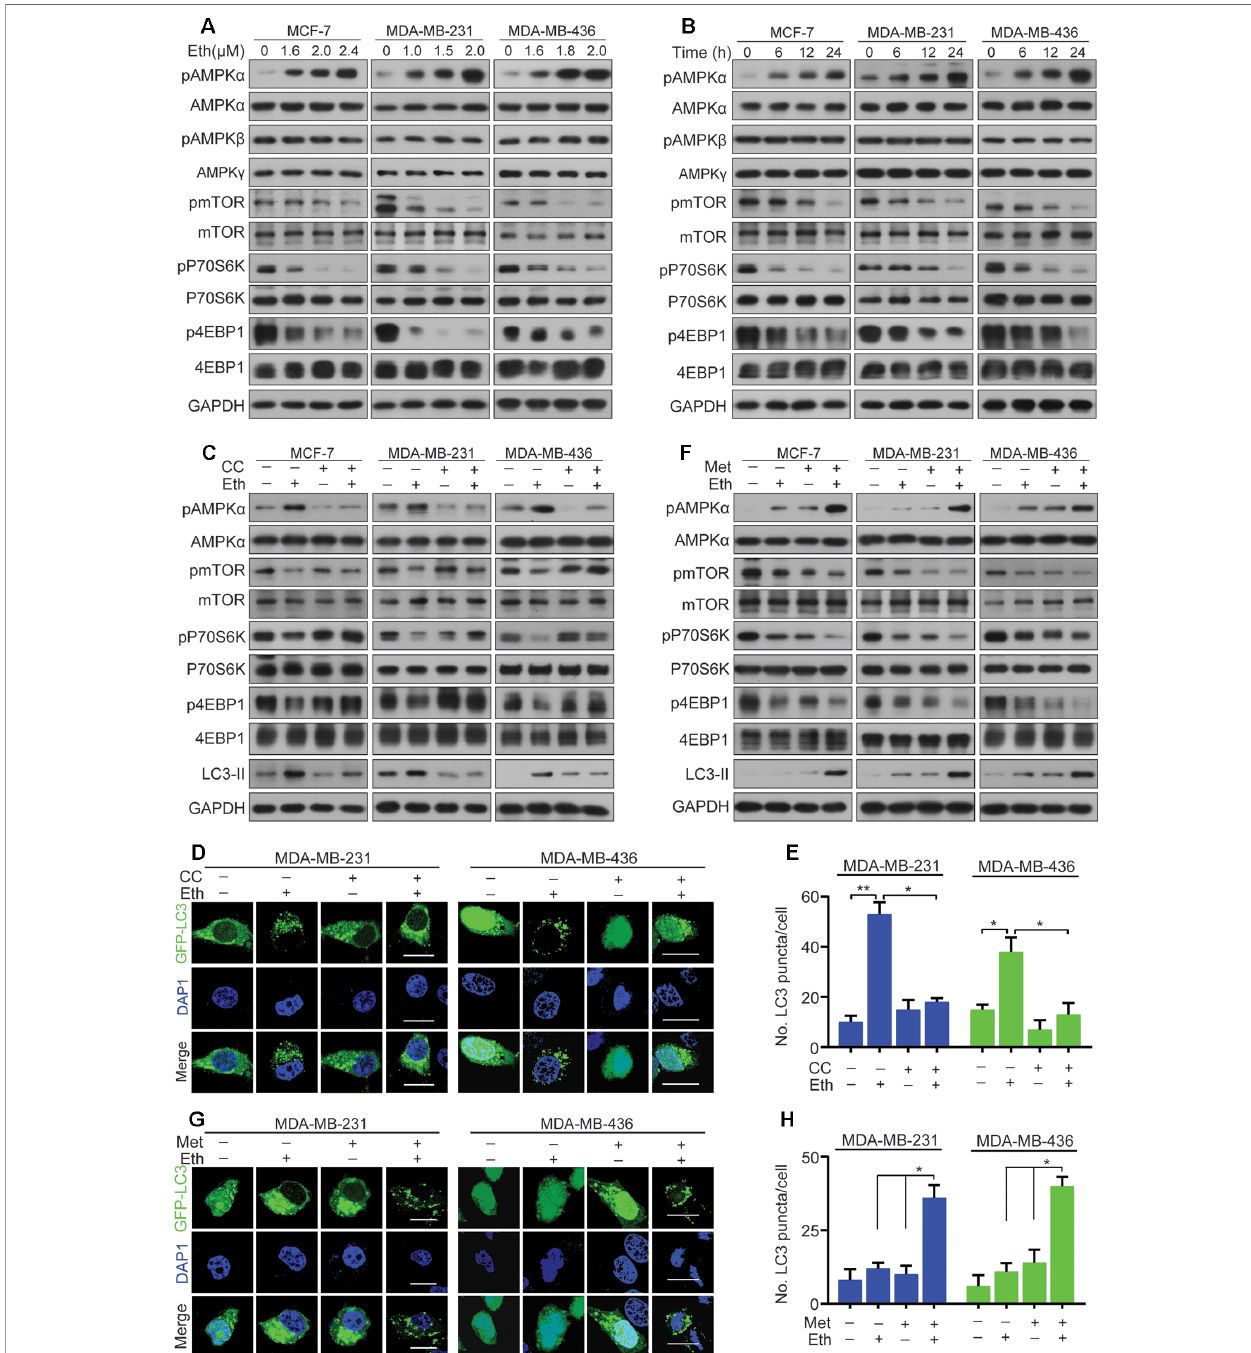
FIGURE 3 | Eth induces autophagy through the AMPK/mTORC1 signaling. (A) : MCF-7, MDA-MB-231, or MDA-MB-436 cells were treated with increasing concentrations of Eth for 24 h. Western blot was performed using antibodies indicated. (B) : MCF-7, MDA-MB-231, or MDA-MB-436 cells were treated with 2.4 µM, 2.0 µM, or 2.0 µM Eth for the indicated times, and cell lysates were subjected to western blot assay. (C) : MCF-7, MDA-MB-231, or MDA-MB-436 cells were treated with Eth (2.4 µM, 2.0 µM, or 2.0 µM) and/or Compound C (CC, 25 µM) for 24 h, and western blot was performed using antibodies indicated. (D) : MDA-MB-231 or MDA-MB-436 cells transfected with pQCXIP-GFP-LC3 plasmid were treated with Eth (2.0 µM) and/or CC (25 µM) for 24 h, and assessed by immuno fl uorescence analyses. Scale bar = 20 µm. (E) : Graph shows quanti fi cation of LC3-positive punctate cells in (D) . (F) : MCF-7, MDA-MB-231, or MDA-MB-436 cells were treated with Eth (1.6 µM, 1.0 µM, or 1.6 µM) and/or metformin (Met, 10 mM) for 24 h, and western blot was performed using antibodies indicated. (G) : MDA-MB-231 or MDA-MB-436 cells transfected with pQCXIP-GFP-LC3 plasmid were treated with Eth (1.0 µM or 1.6 µM) and/or Met (10 mM) for 24 h, and assessed